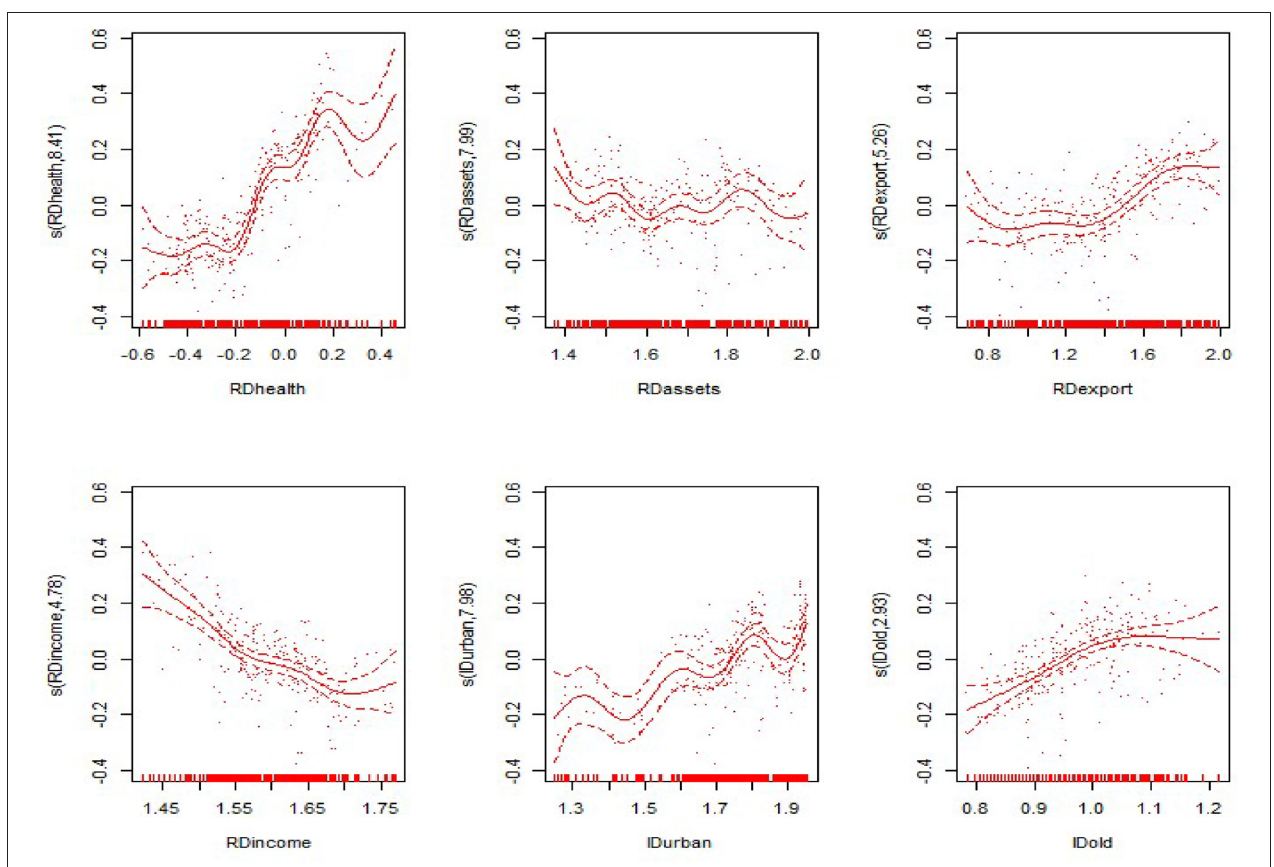
FIGURE 8 | Comprehensive effects of the explanatory variables on per capita GDP in the eastern